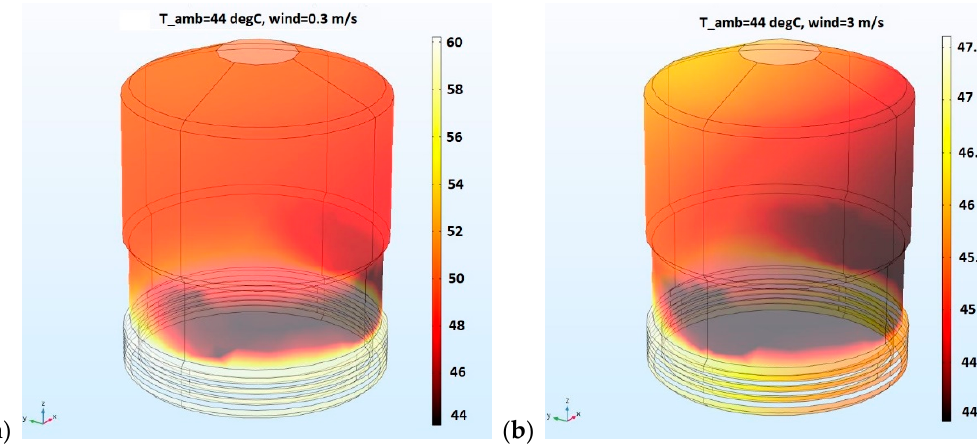
Figure 7. Example simulation results depicting temperature distribution at the surface of the lamp in the steady state for T amb = 44 °C and wind speed equal to ( a ) v = 0.3 m/s; ( b ) v = 3 m/s.